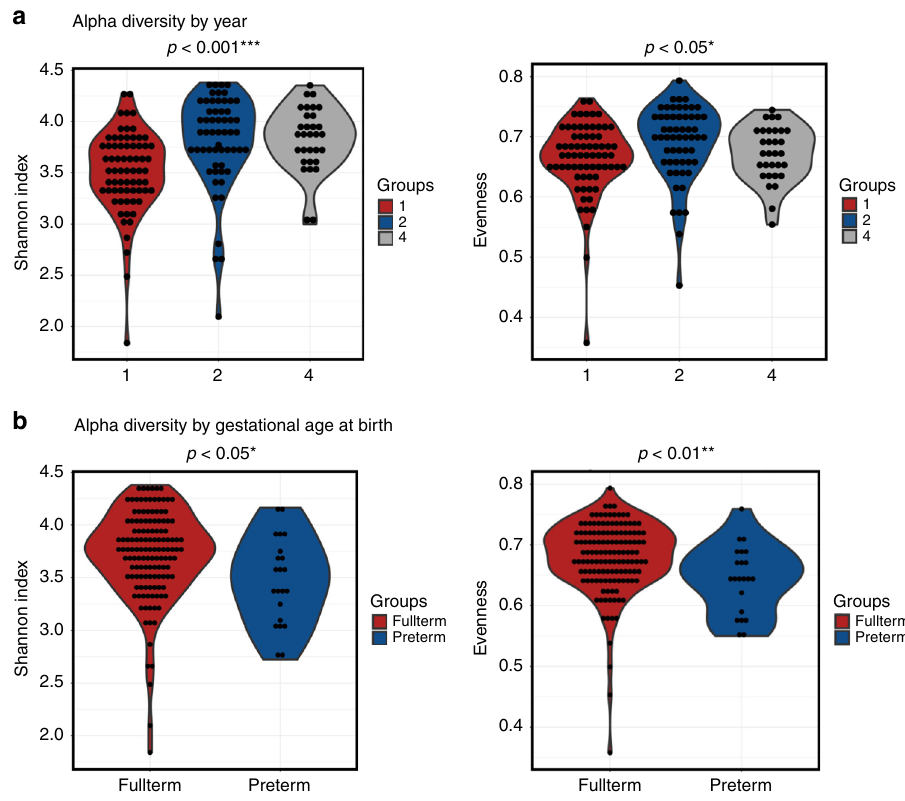
Fig. 2 Alpha diversity increases with age. Alpha diversity shown as Shannon Index and Evenness based on a year of sample and b gestational age at birth. Source data are provided as a Source Data fi le. (* p < 0.05, ** p < 0.01, *** p <